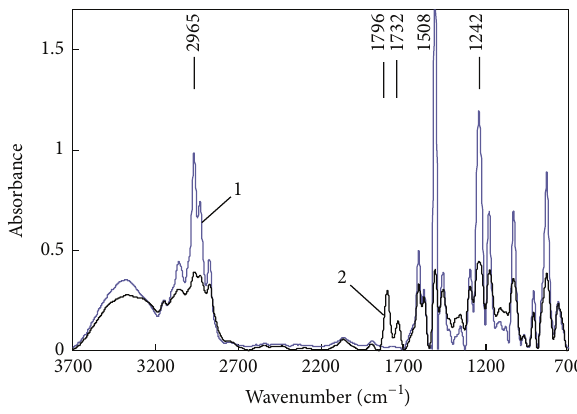
Figure 6: DSC curves of curing reaction of ED-20 resin with IMTHPA hardener in the presence of interaction products: (1) 2- ethyl-4-methylimidazole + IMTHPA; (2) 1-butyl-3-methylimida- zolium bromide +